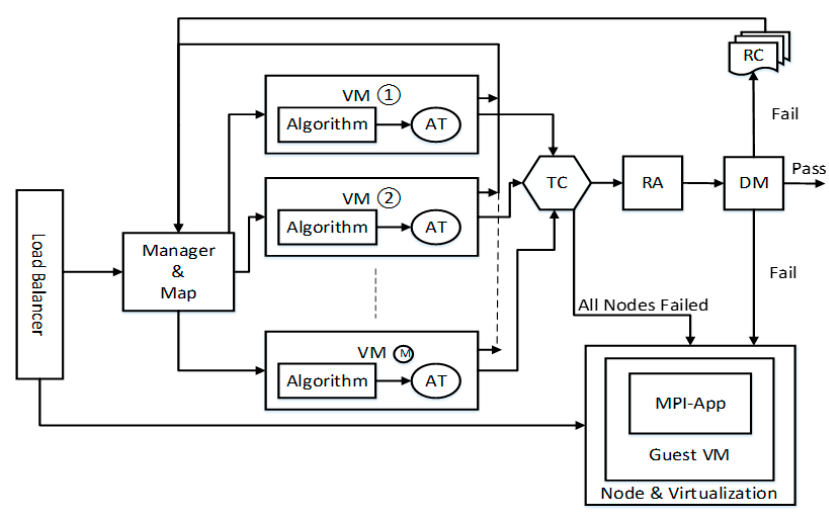
Figure 3. Our proposed Architecture proposed in this paper (PRP-FRC) hybrid architectural structure.